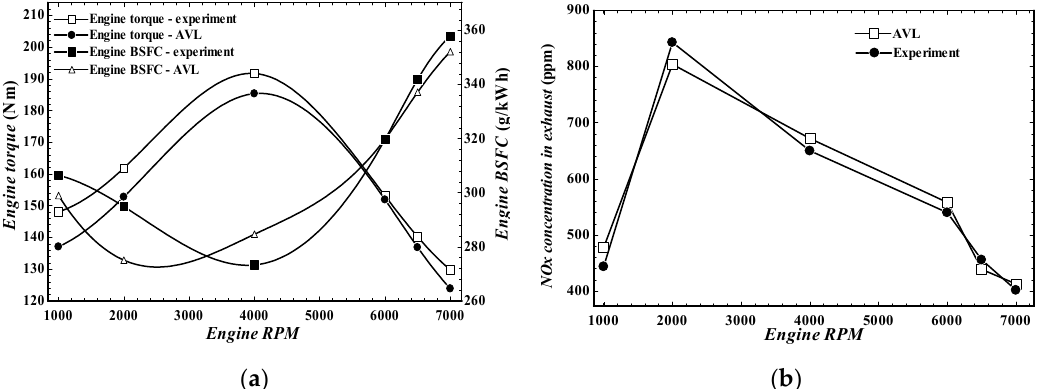
Figure 3. ( a ) Engine Torque and BSFC and ( b ) NOx concentration in the exhaust in the AVL model and experimental tests obtained from running the engine by gasoline at full load and various RPMs.